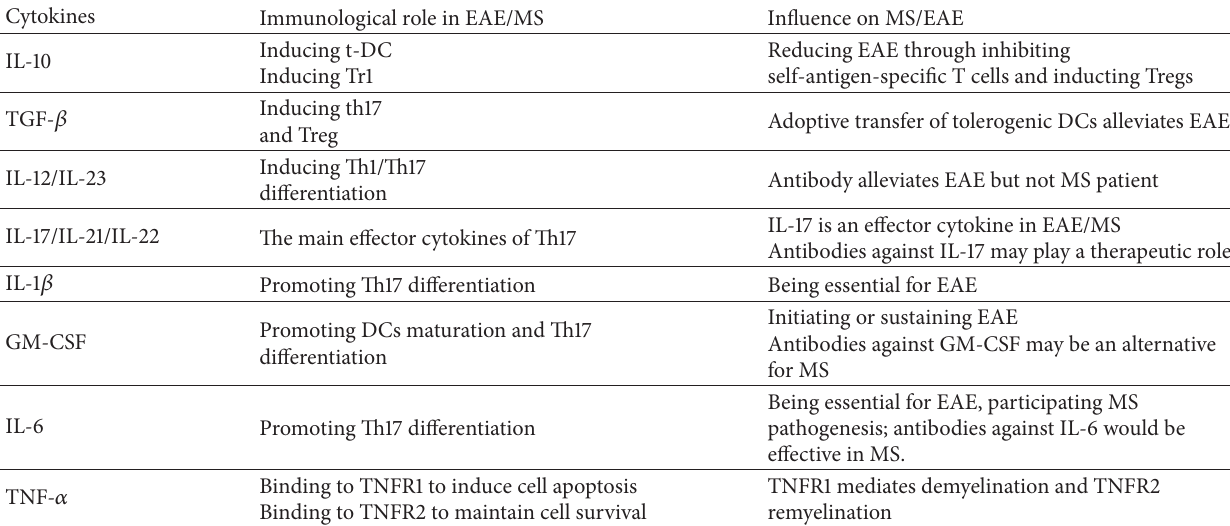
Table 4: Cytokines associated with DC and